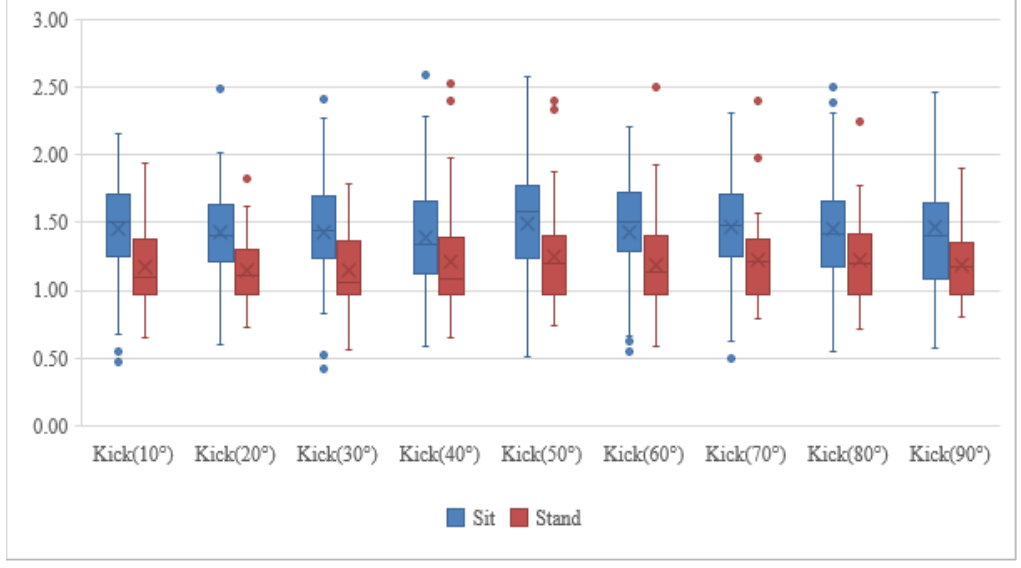
Figure 4. The box plot of kick action average value of 45 male subjects sitting and standing at 10 ◦ ~90 ◦ .